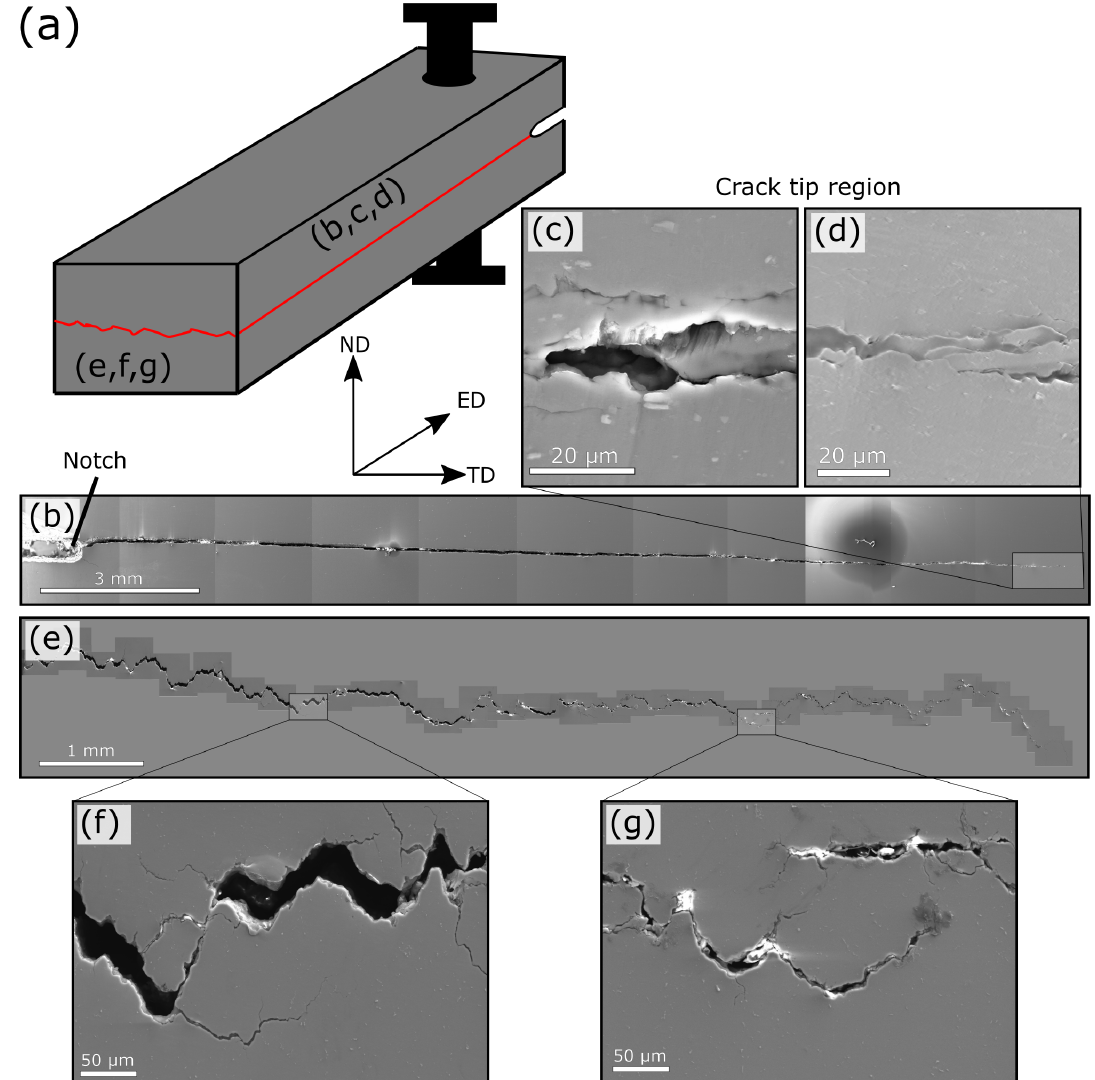
Figure 11. A schematic figure of a cracked DCB specimen in ( a ), where the base has been cut along the transverse direction to reveal the crack. SE-SEM images of the crack along the extrusion direction and the transverse directions are shown in figures ( b , e ), respectively. ( c , d ) are higher magnification SE-SEM images of the crack tip along the extrusion direction. ( f , g ) are two higher magnification images of cracks in the transverse